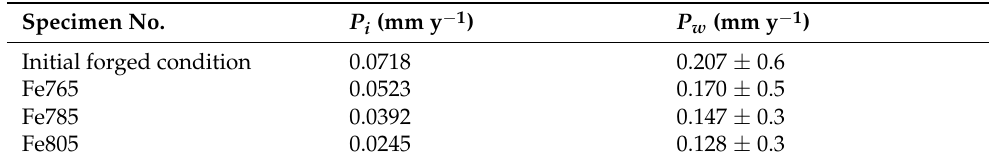
Table 3. Biodegradation rate of the initial forged and different annealed conditions in Hank’s solution. Specimen